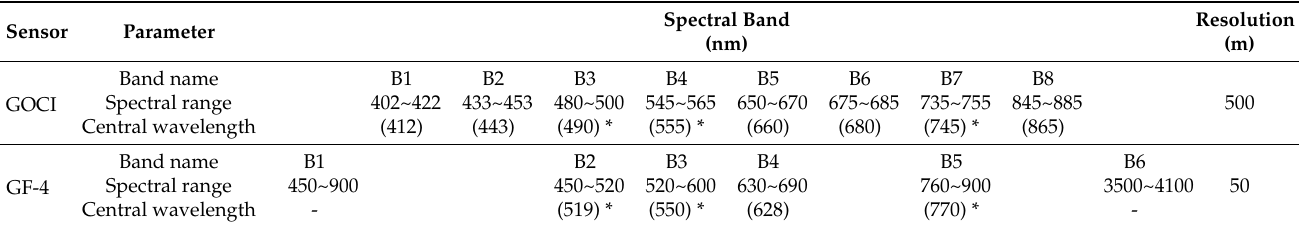
Table 2. The comparison of bands between GOCI and GF-4